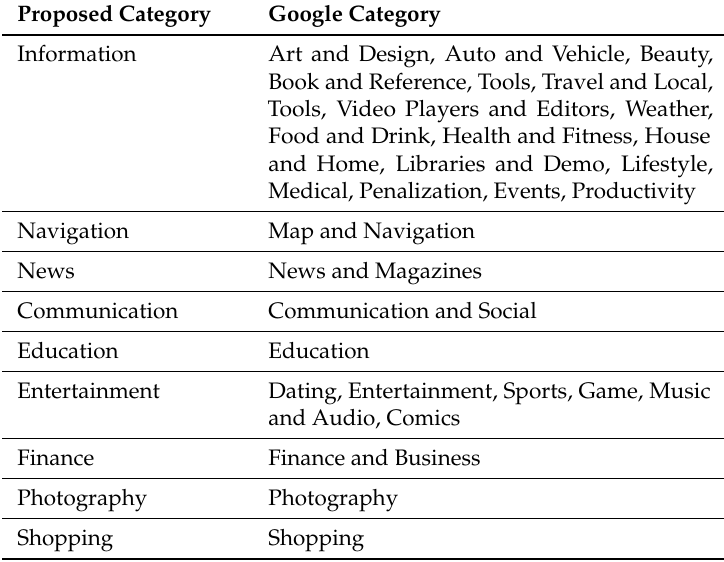
Table 1. Google Play’s app categories and the proposed app categories.